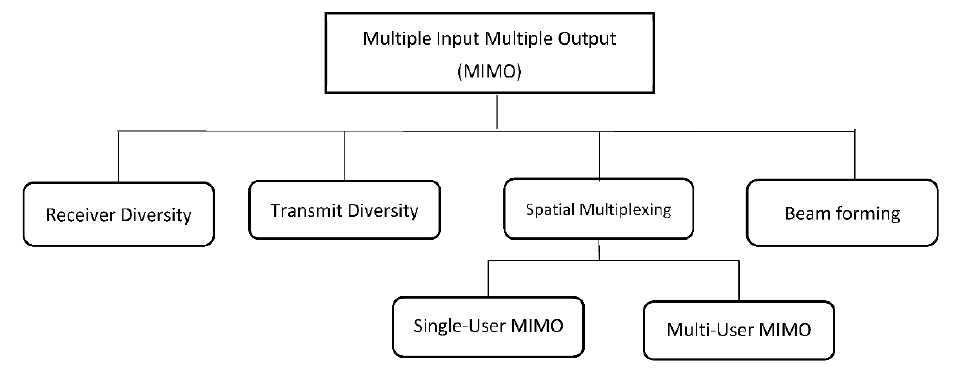
Figure 13. MIMO classification.